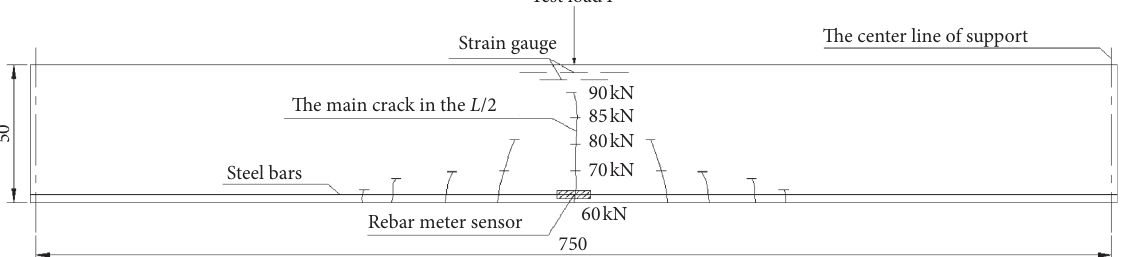
Figure 5: Schematic diagram of the crack development of #1 specimen at 1.25 N